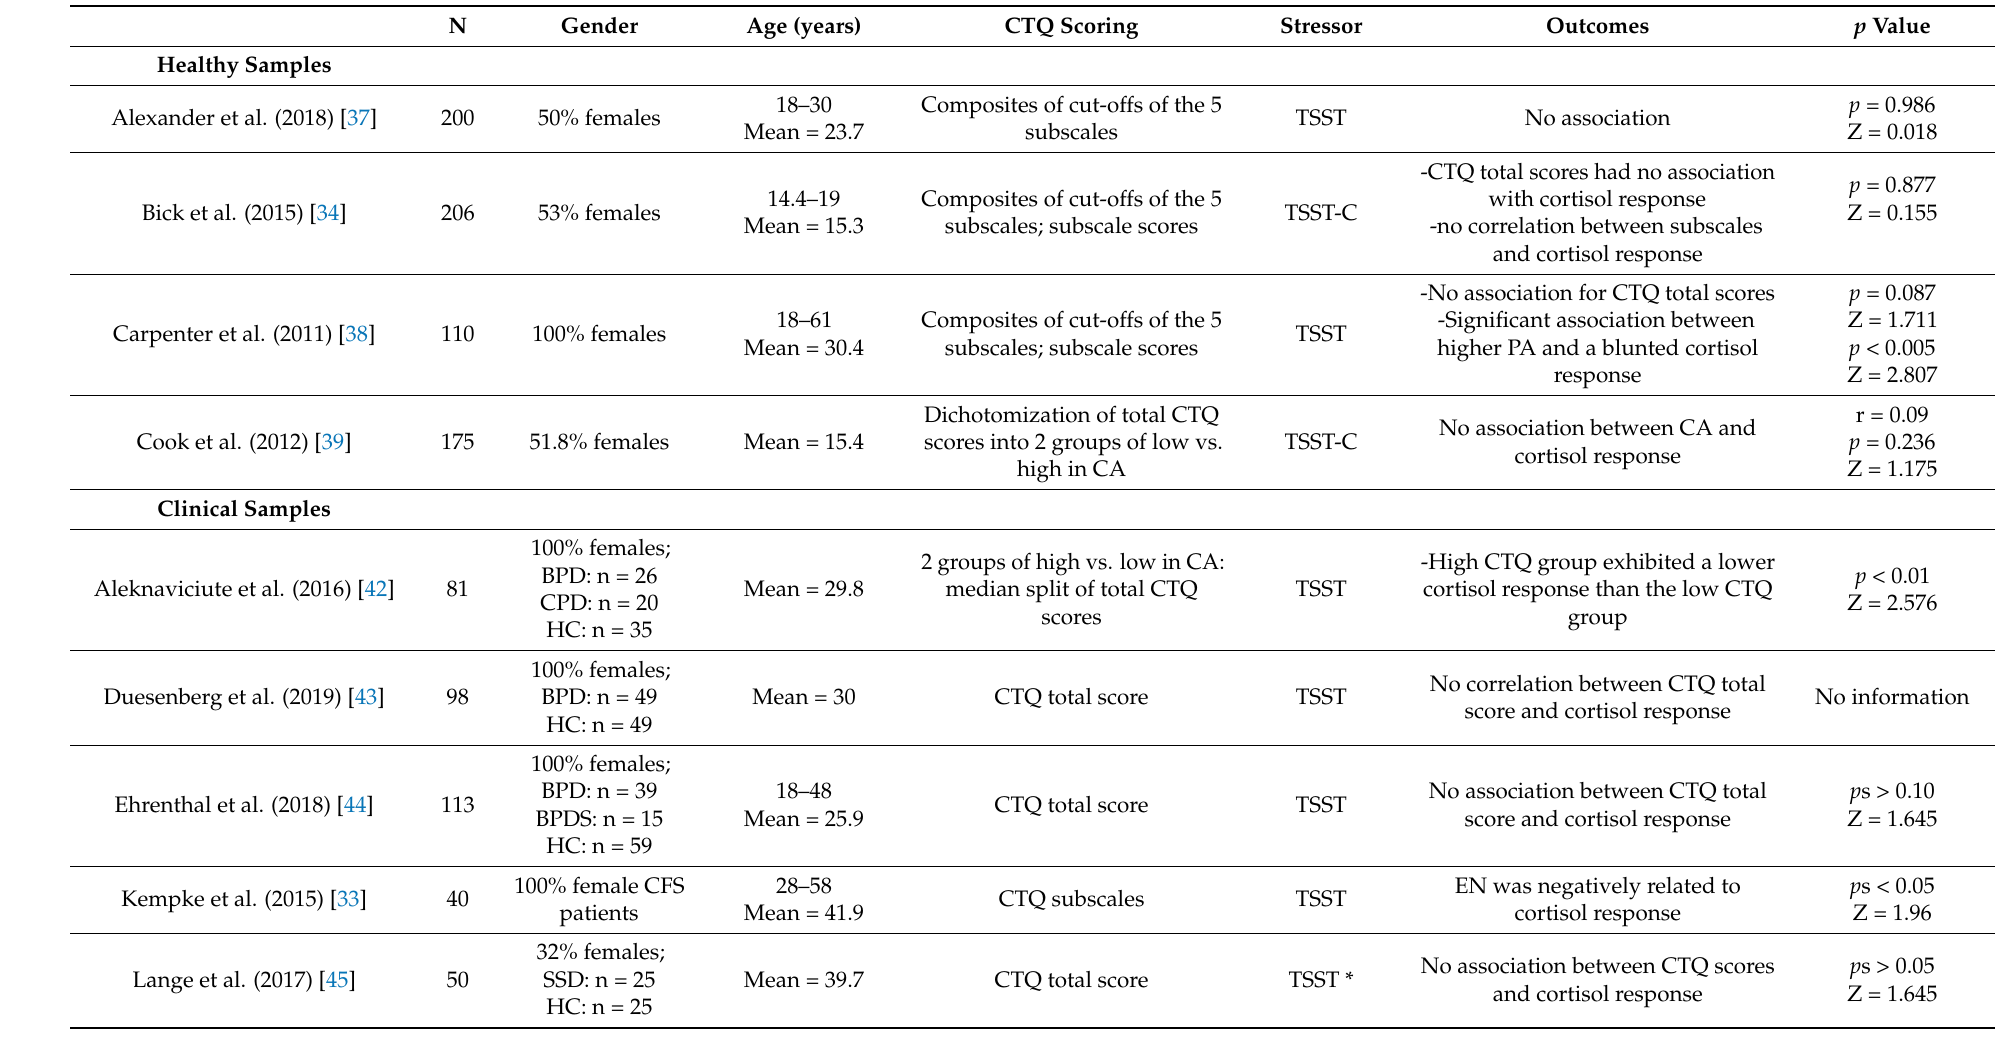
Table 2. Summary of 12 studies included in the